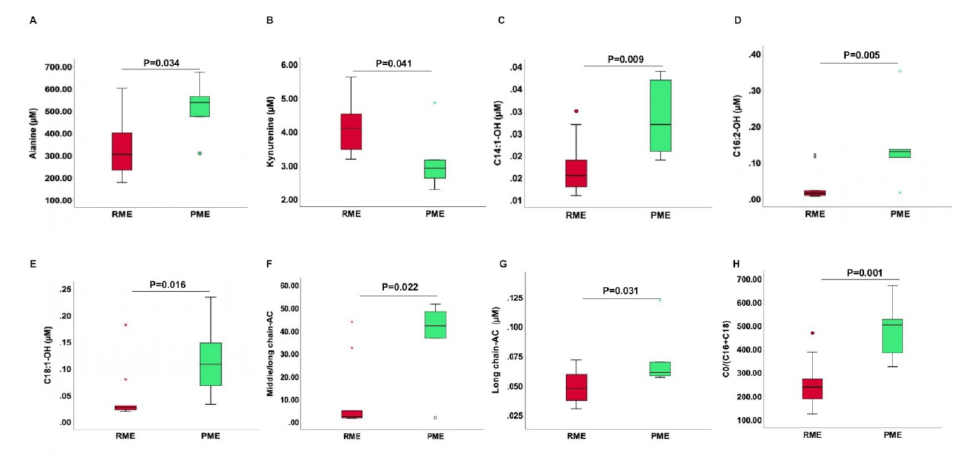
Figure 3. Concentration of different metabolites in serum in patients with HFpEF and RME. The concentration of Alanine ( A ), kynurenine ( B ), C14:1-OH ( C ), C16:2-OH ( D ), C18:1-OH ( E ), medium- /long-chain-ACs ( F ), long-chain-ACs ( G ), and C0/(C16 + C18) ( H ) as an indicator of the function of CPT1B in serum are shown as boxplots in patients with RME (red) vs. PME (green). AC: acylcarnitine, Cx:y: where x is the number of carbons in the fatty acid side chain; y is the number of double bonds in the fatty acid side chain; OH: hydroxyl. PME: Preserved Muscle Endurance; RME: Reduced Muscle